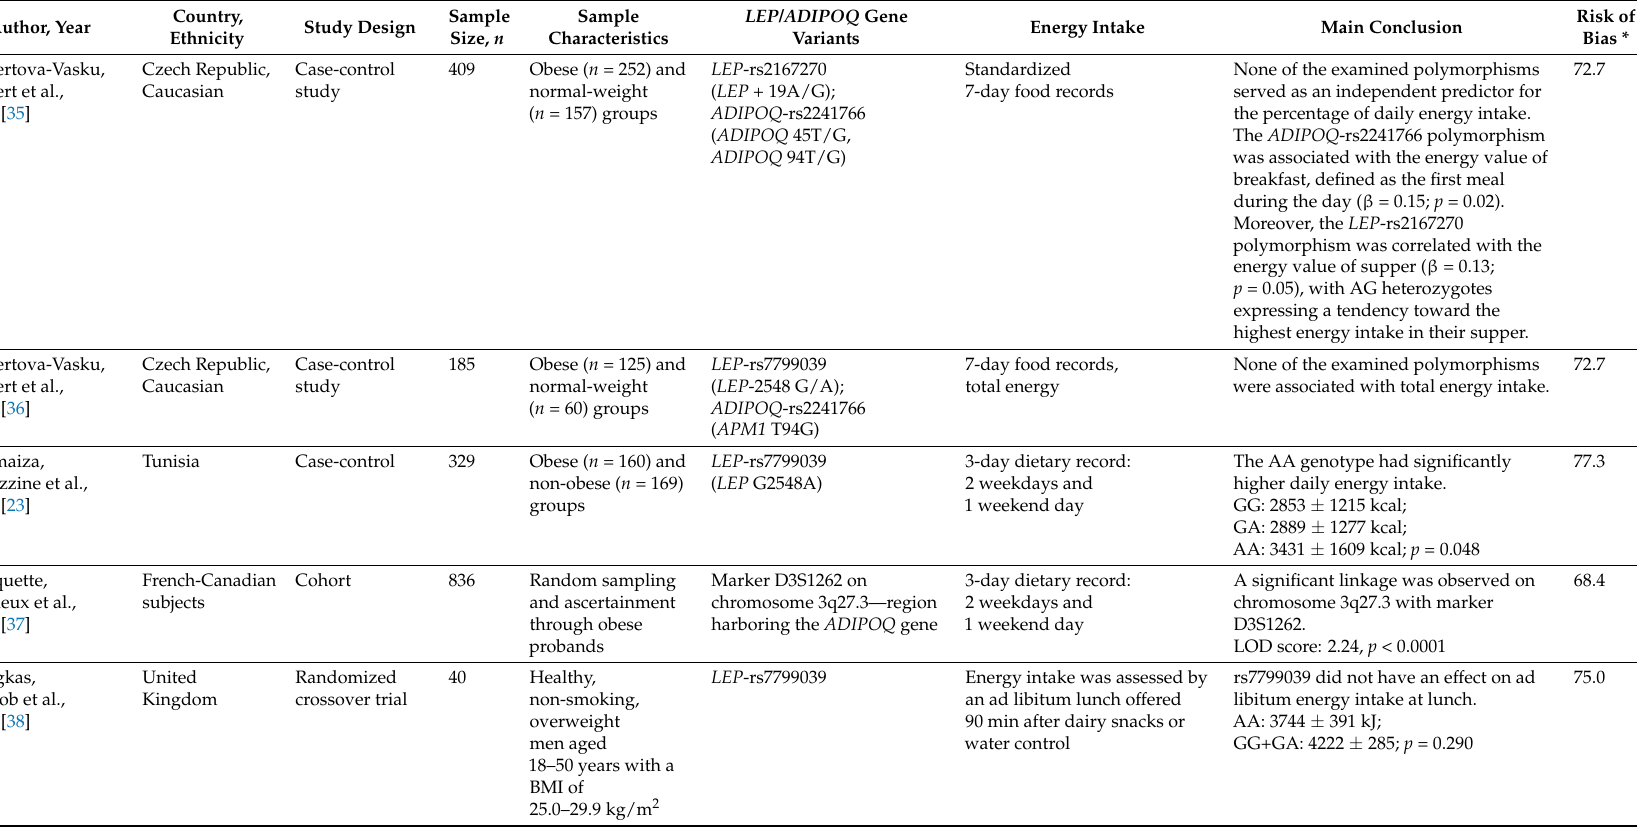
Table 1. Summary of descriptive characteristics of the included